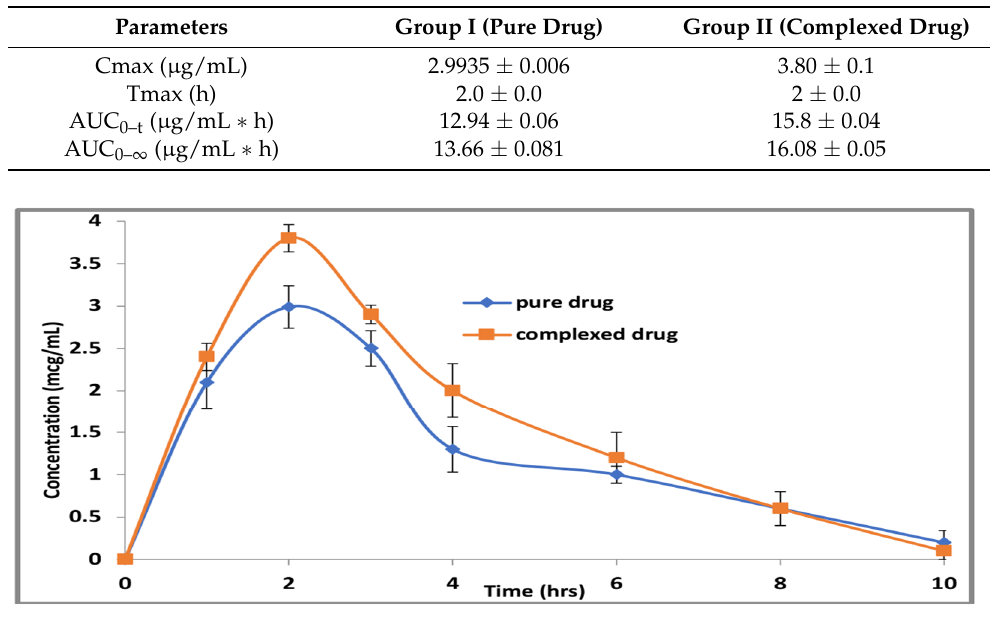
Figure 7. The plasma concentration–time curve of the pure drug (80 mg/kg p.o.) and complexed drug (equivalent to 80 mg/kg CBZ) administered in rats.